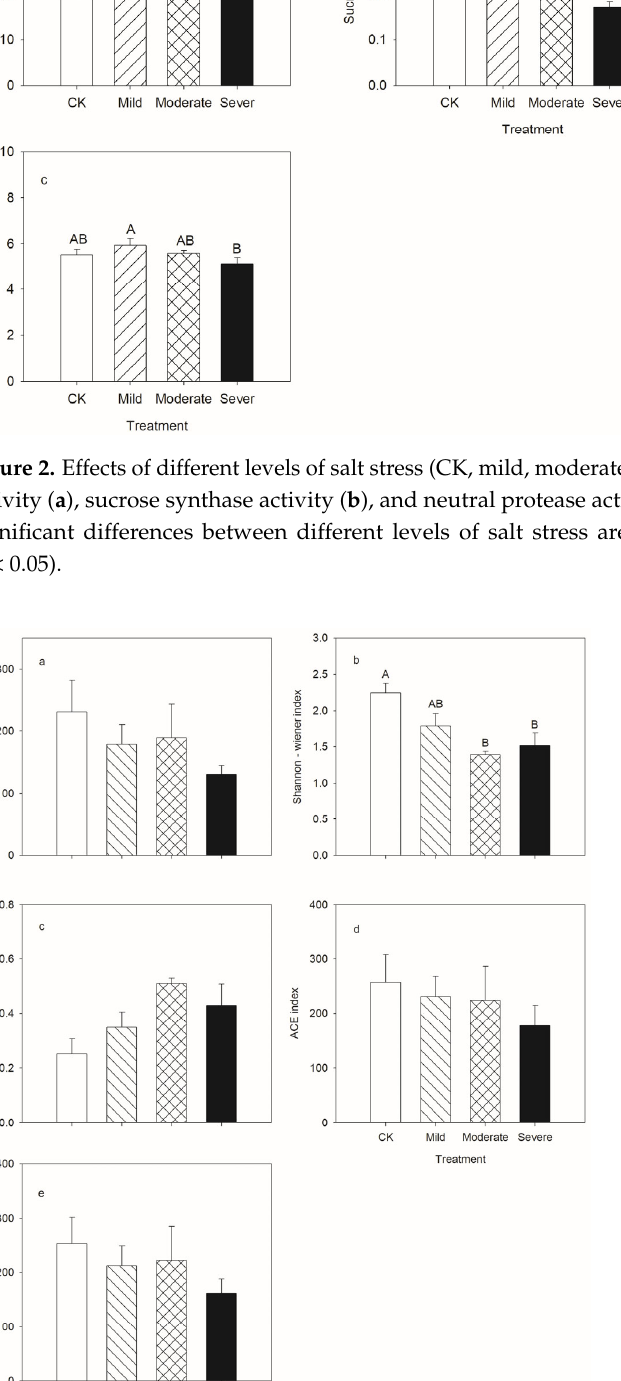
Figure 4. Principal coordinate analysis (PCoA) of endophytic fungal dissimilarity (Bray–Curtis). The Ascomycota and Basidiomycota phyla were the dominant fungi and showed rel ‐ ative abundances ranging from 78.99% to 93.10% and from 6.70% to 20.61% across all the